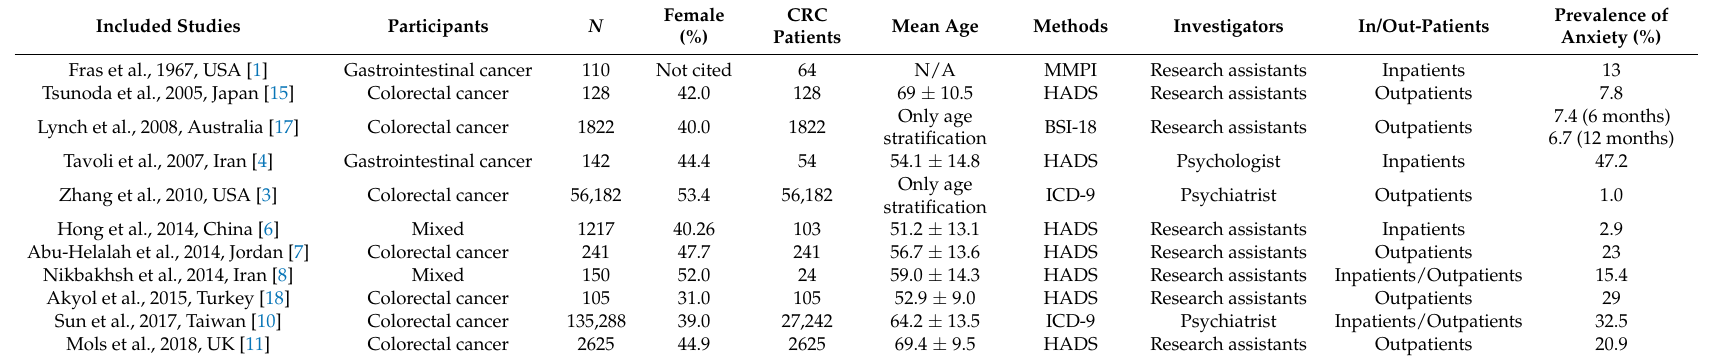
Table 2. Characteristics and analyses of included studies for prevalence of